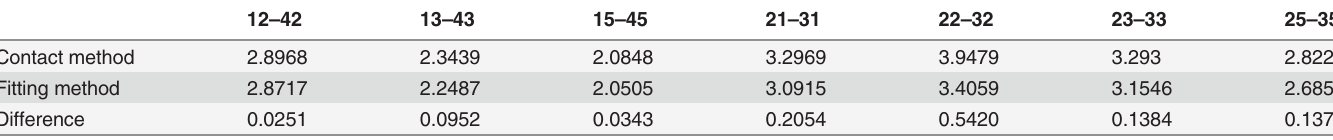
Table 3. Measurement results of the straight-line distance at the Y-axis (unit: